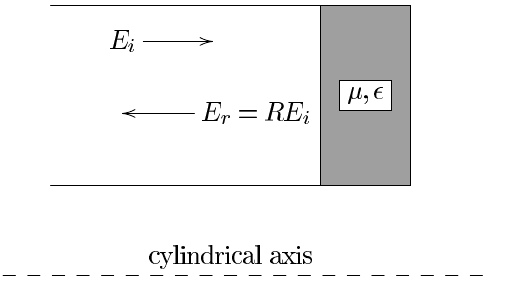
FIG. 13. Coaxial geometry for calculation of the ferrite reflection coefficient.